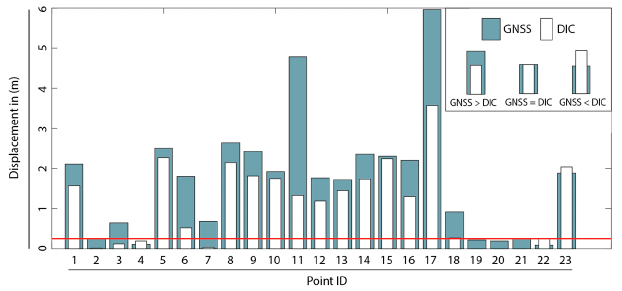
Figure 1. Displacement derived with GNSS (grey, background) and with DIC (white, foreground) per measurement point ID within the CdV AoI, in meters. Red line marks the assumed minimal sensitivity of all assessed DIC codes at ~1 pixel, or 0.25 m. The underlying run has been performed with a FFT-based code, a scan window size of 64 × 64, and with a Wallis and spatial vector filter; the results can be accounted as being exemplary for all conducted DIC runs.